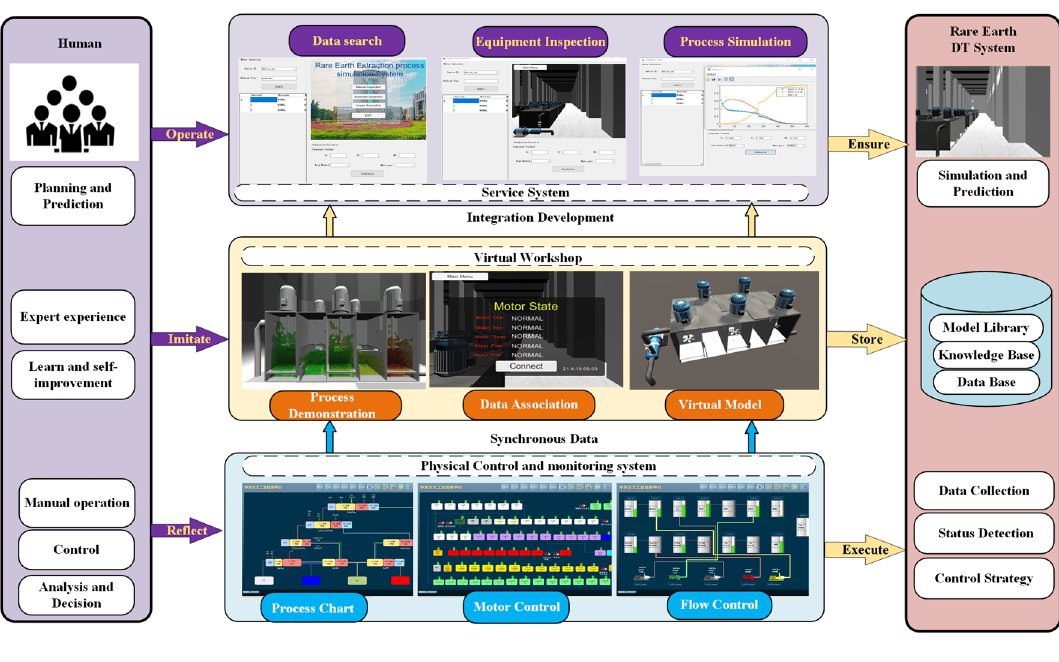
Figure 10. Test of rare earth DT